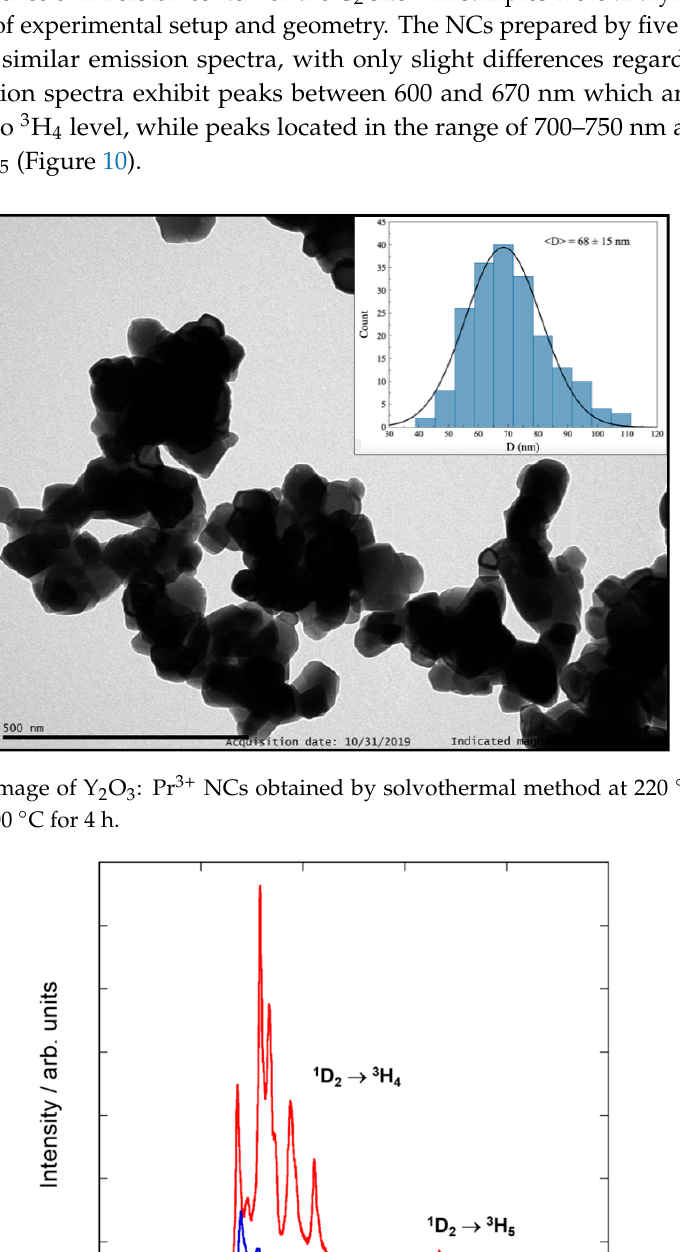
Figure 9. Emission spectra from C 2 (red, λ ex = 292 nm) and S 6 (blue, λ ex = 330 nm) sites at RT of Y 2 O 3 : Pr 3+ NCs prepared by solvothermal method at 220 °C followed by calcination at 1000 °C for 4 h.